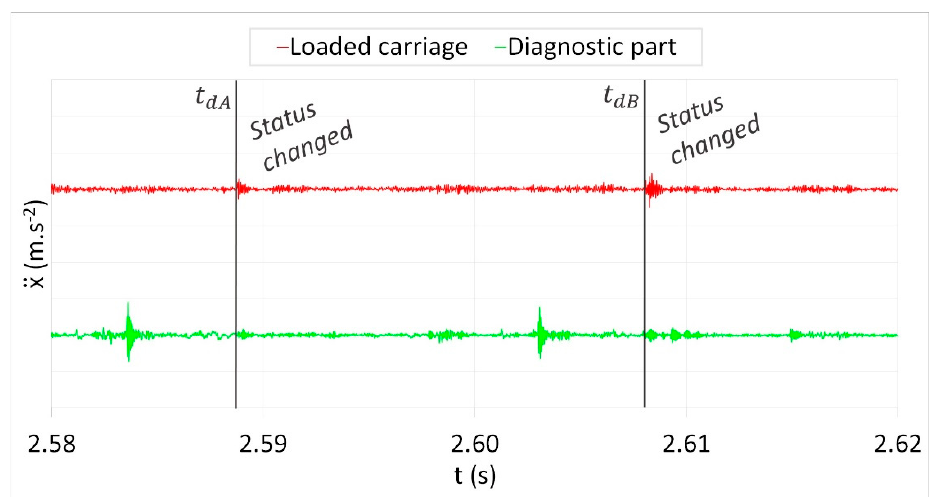
Figure 23. The time graph of acceleration by loaded carriage crossing over the simulated damage: ordinate tick marks: 100 ms − 1 , processed in DeweSoft. Table 8. Time period and its parameters according to Figure